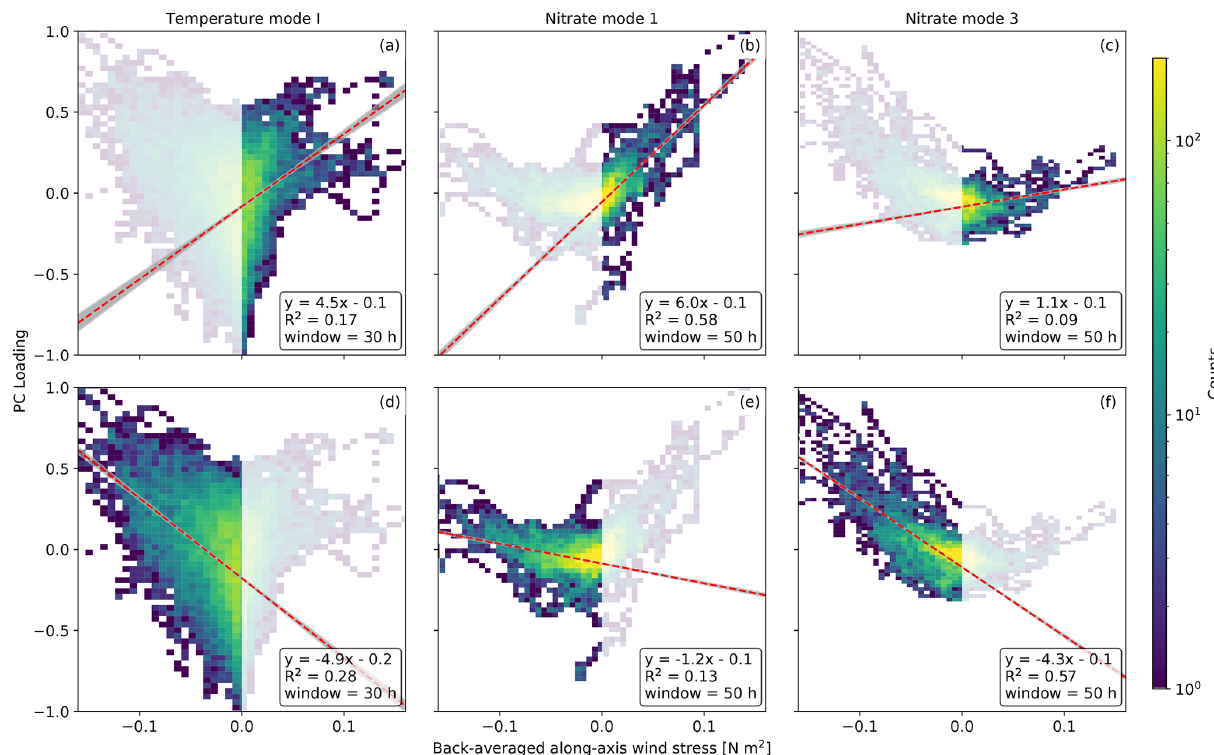
Figure 9. Two-dimensional histograms of the PC loadings for temperature mode I (a, d) , nitrate mode 1 (b, e) and nitrate mode 3 (c, f) versus the temporally back-averaged spatial median of along-axis wind stress calculated from the HRDPS wind record according to Eq. (2). Bayesian linear regression is performed separately for positive southeasterly (a–c) and negative northwesterly (d–f) wind stress. Regression statistics shown include a mean best fit (red line and equation), a 99% confidence interval (gray envelope), a correlation coefficient ( R 2 ) and a wind stress back-averaging window tuned to maximize R 2 . The temperature mode I correlation is strongly symmetric between positive and negative wind stress, and the back-averaging window is approximately 30h for both directions. Conversely, the nitrate modes 1 and 3 correlations are strongly asymmetric between wind stress directions, and the back-averaging window is thus determined according to the wind stress direction that yields the highest regression slope and R 2 value. This direction is positive for nitrate mode 1 (b) and negative for nitrate mode 3 (f) , with a 50h averaging window for both